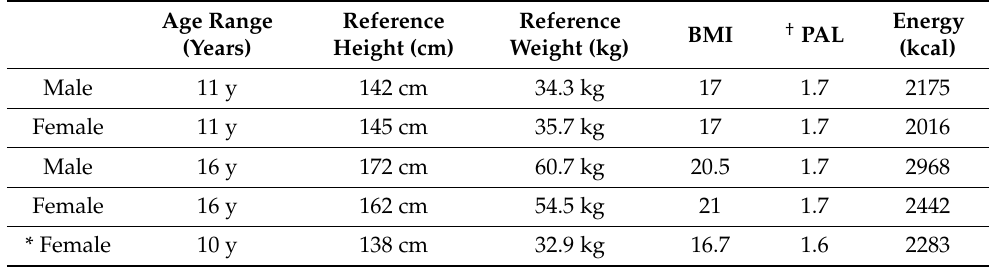
Table 1. Demographic data used for the LCHF case studies and for the ADG